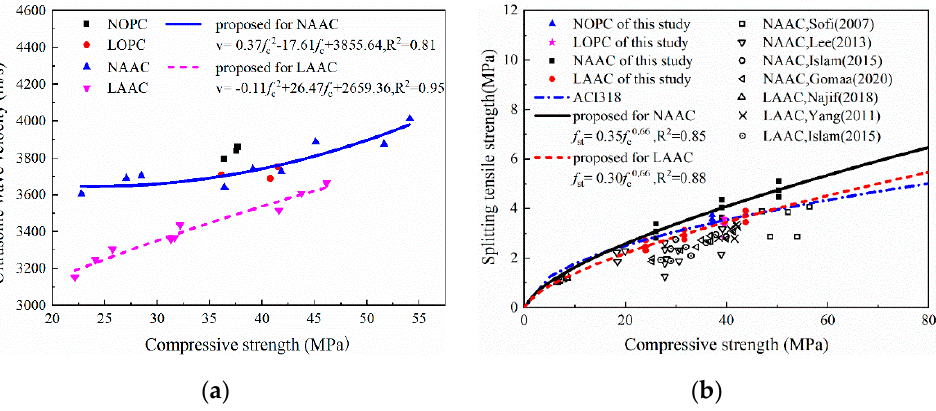
Figure 6. The mechanical properties of the AAC with different compressive strengths: ( a ) the ul- trasonic pulse velocity (UPV); ( b ) splitting tensile